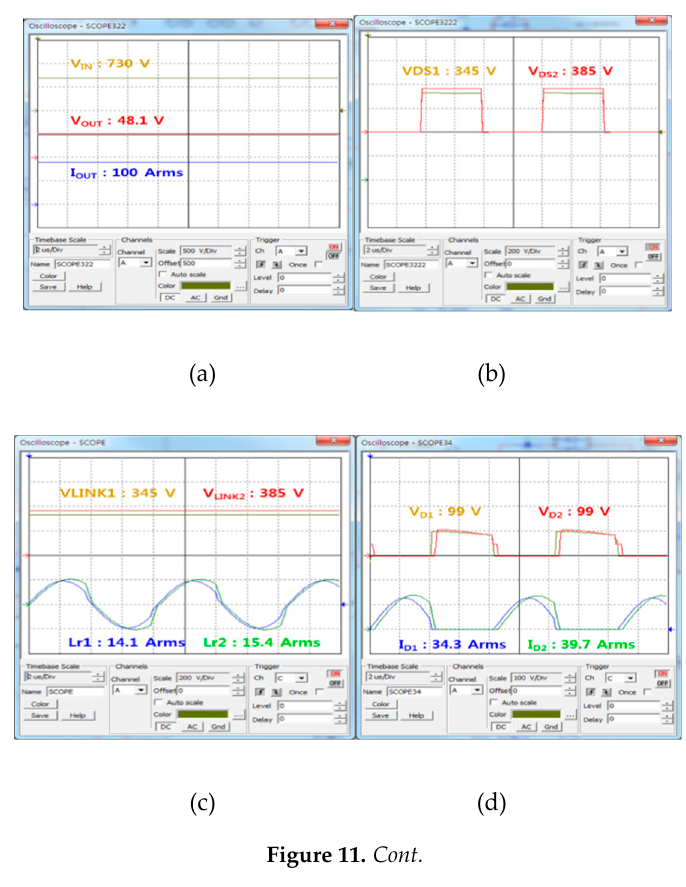
Figure 10. Simulation circuit of the auto-balancing converter.